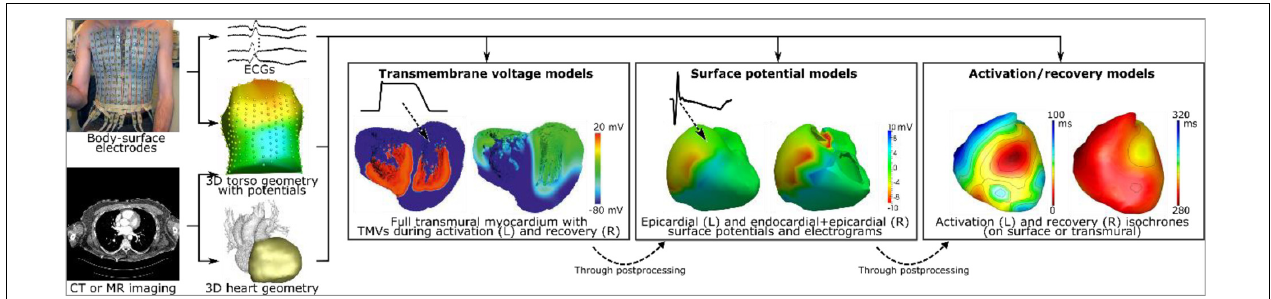
FIGURE 2 | Electrocardiographic imaging requires recording of body-surface potentials and the acquisition of a torso-heart geometry through computed tomography (CT) or magnetic resonance (MR) imaging. The electrical characteristics of the heart can then be computed by employing one of the “source models,” i.e., models of cardiac electrical activity that explain the recorded body-surface potentials. Globally, these source models are categorized as: transmembrane voltage (TMV) models, surface-potential models (either epicardial-only or endo-epicardial surface), and activation/recovery-based models. It is possible to compute surface potentials and electrograms from TMVs, and to compute activation and recovery sequences from electrograms, but not the other way around. Image in part reproduced with permission from: Cluitmans (2016); Weiss et al. (2007), and Van Dam et al.